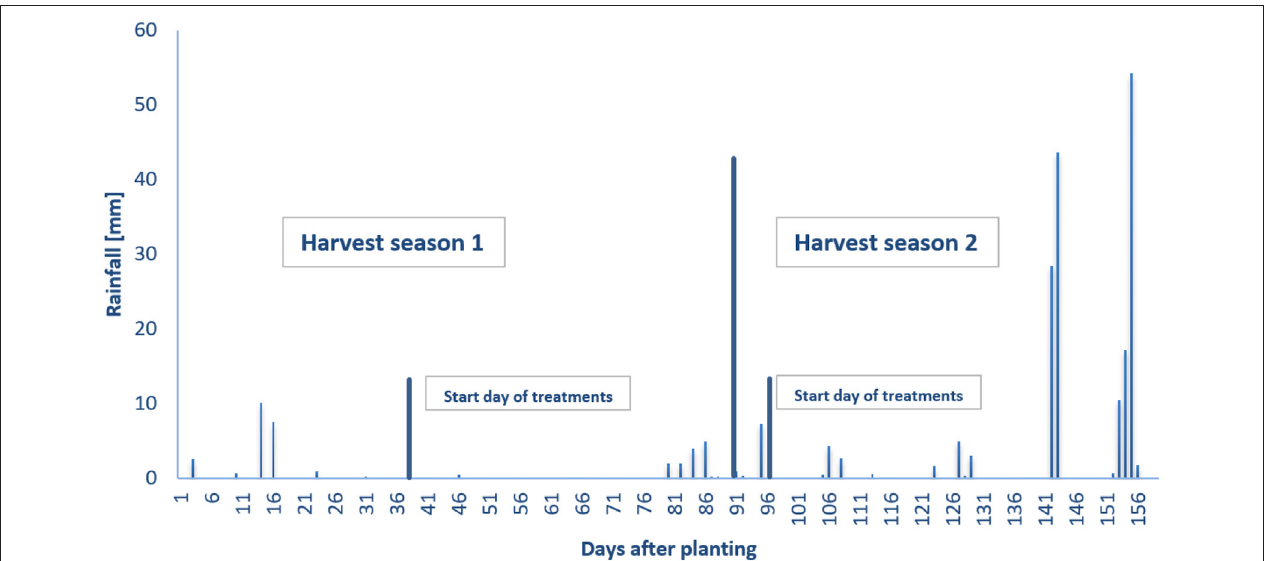
FIGURE 1 | Daily rainfall during growth